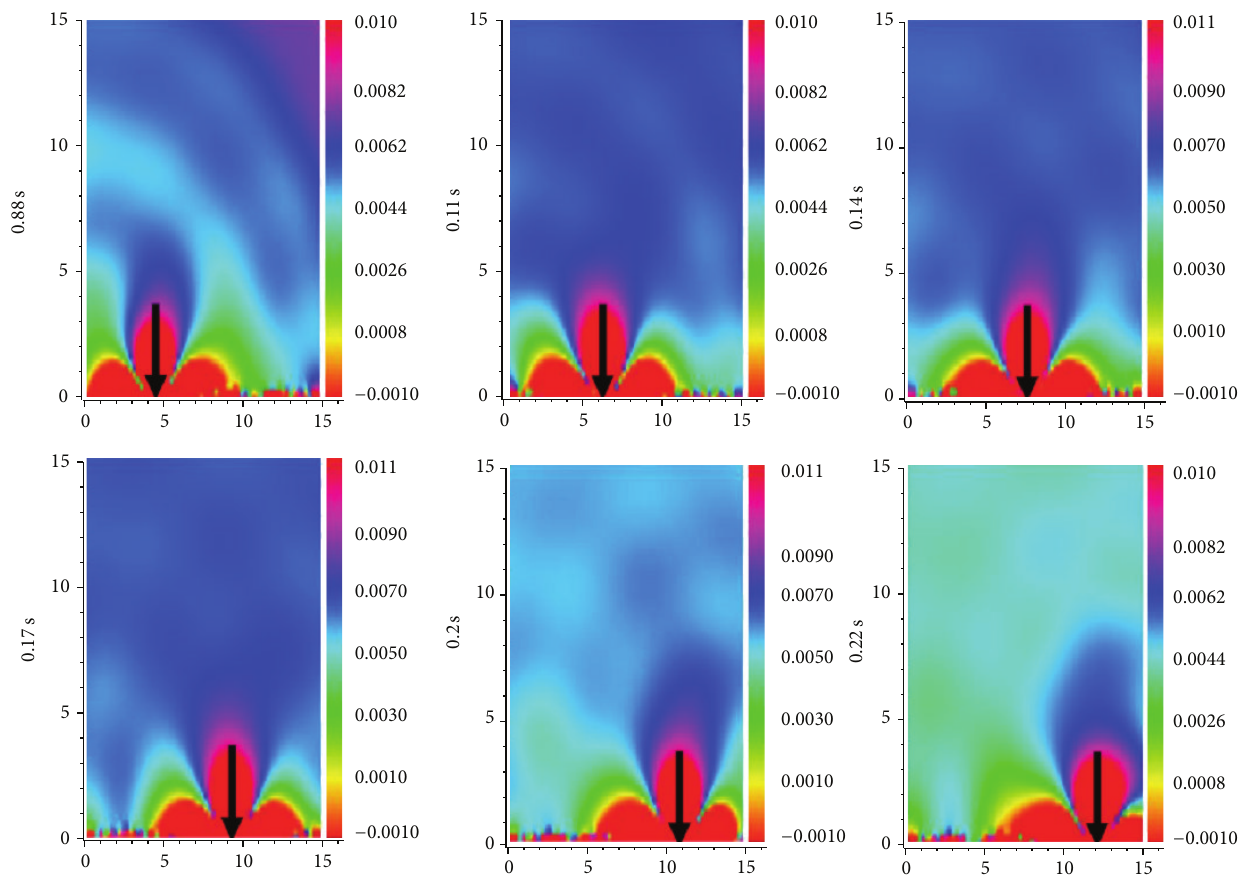
Figure 6: Acoustic pressure field (Pa) along the beam (15m) at different positions of moving